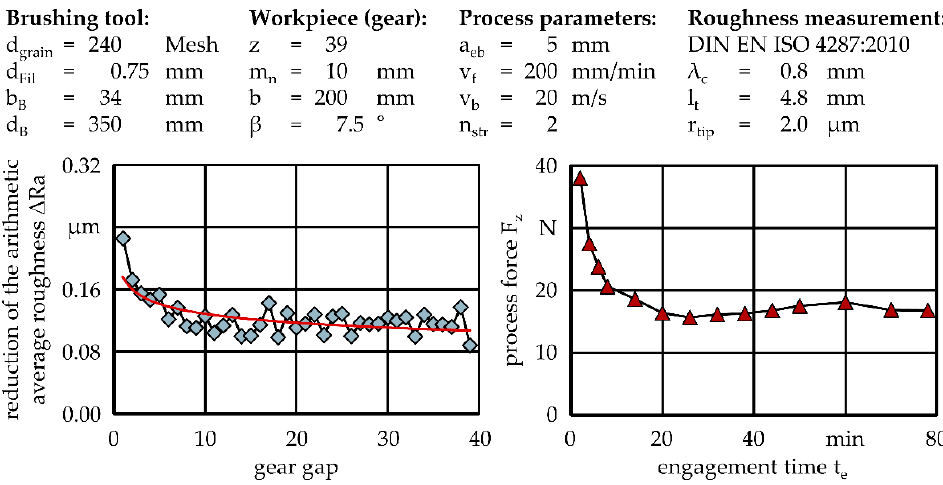
Figure 9. Reduction in the arithmetic average roughness Δ Ra and the correlating process force F z for the test series with tool specification S240x0.75 and an initial roughness of Ra ini ≅ 0.4 μ m.